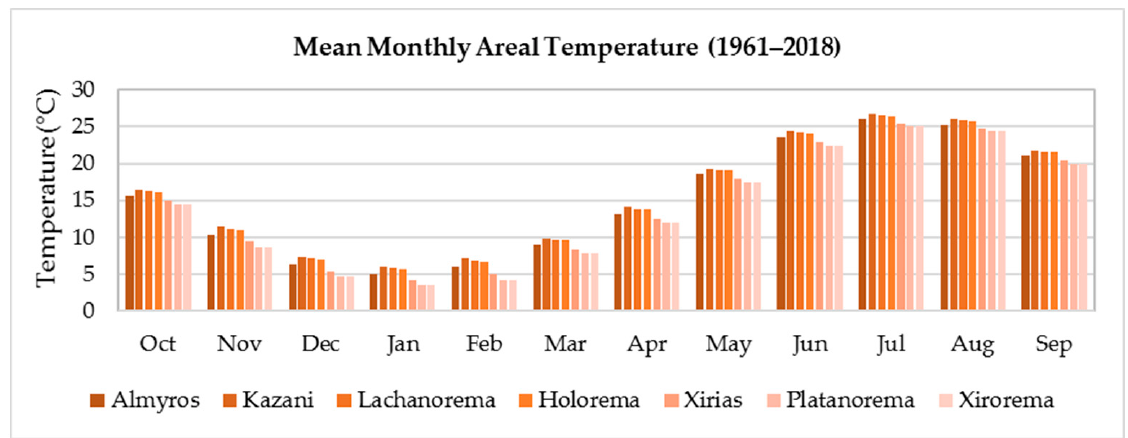
Figure 8. Mean monthly areal temperature at the mean elevation of the Almyros basin and the sub ‐ basins.